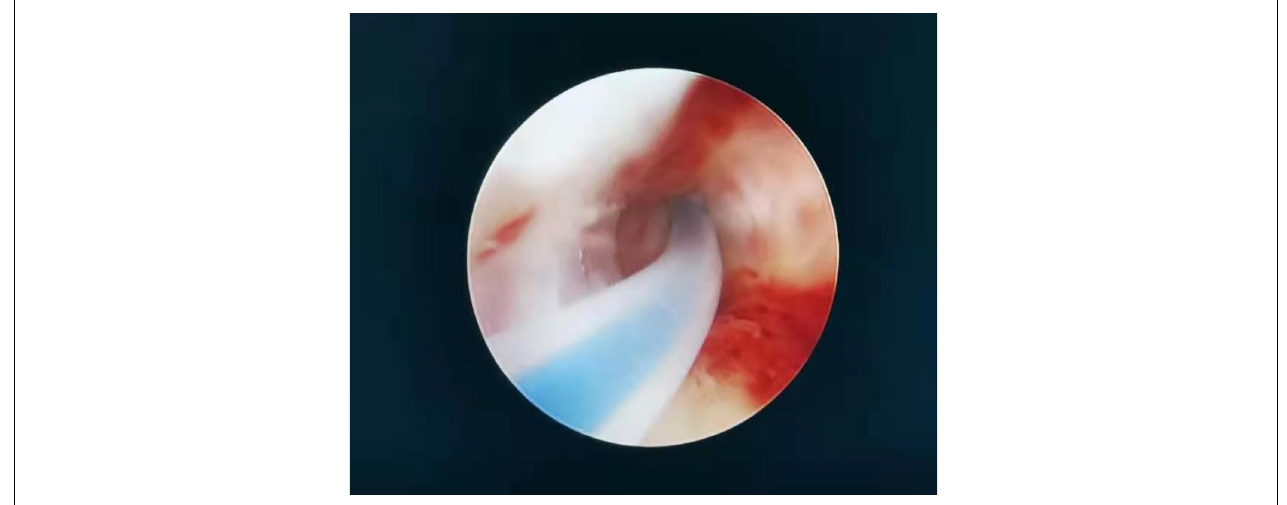
FIGURE 1 | A catheter was inserted through the operation channel of the hysteroscope into the fallopian tube ostia under the guidance of the hysteroscope. Care was taken to maintain a space between the catheter and the fallopian tube ostia so that the catheter could be inserted in the correct direction. The operator fixed the catheter, and the diluted methylene blue solution was injected with a 20-mL syringe by the surgical assistant.